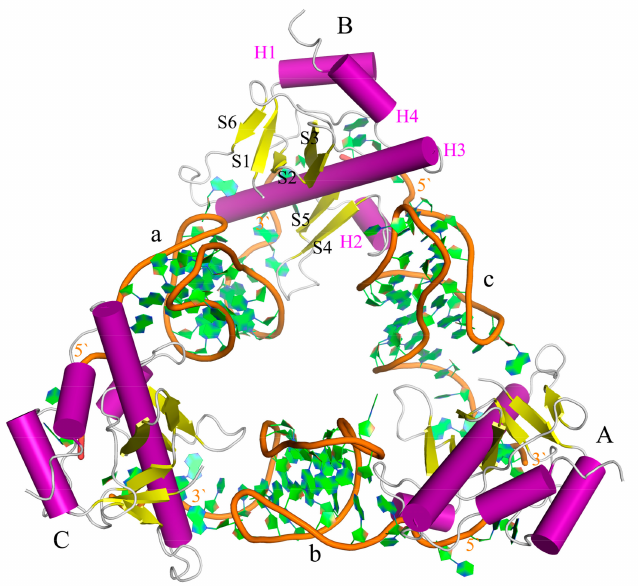
Figure 1. Structure of three protein toxins and three noncoding RNA antitoxins complex (ToxIN) shown in cartoon representation. Three ToxNs (protein toxins) and ToxIs (specific RNA antitoxins) are labeled with uppercase and lowercase letters, respectively. Secondary structures of ToxN(B) are also labeled with α -helices H1 to H4 and β -strands S1 to